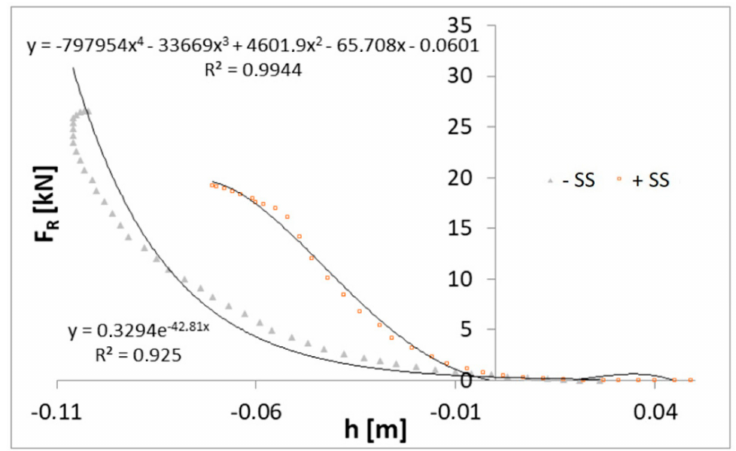
Figure 12. Correlation between the impact force F R and the height h at the drop hammer weight of 100 kg and the drop height of 1.6